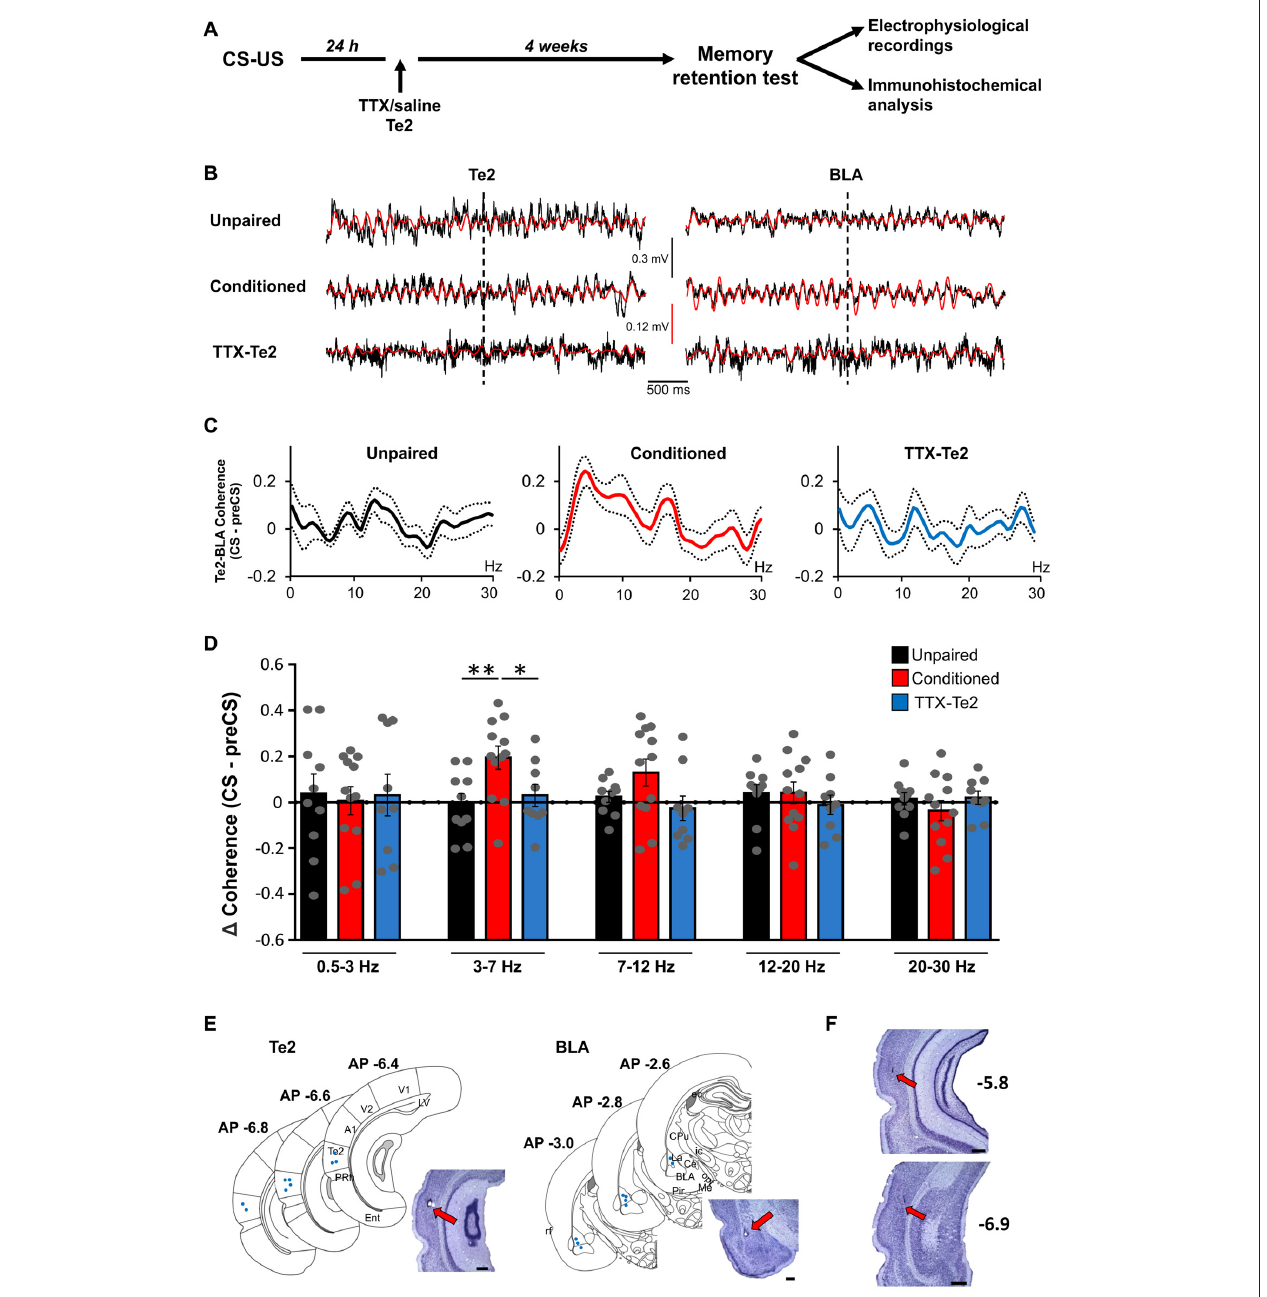
FIGURE 2 | Te2 silencing upon memory consolidation prevented the increase in synchrony between Te2 and BLA activity during long-term memory retrieval. (A) Schematic diagram illustrating the experimental procedure employed to identify the role of Te2 in the retrieval vs. storage of fearful memories. (B) Representative local field potential (LFP) traces recorded in Te2 (left) and BLA (right) with their 3–7 Hz filtered signal superimposed (in red) around the first CS (dotted line). (C) Changes in the coherence between the BLA and the Te2 in unpaired ( n = 10), conditioned ( n = 12) and TTX-treated animals ( n = 9) retrieving long-term memories. (D) Coherence between the Te2 and BLA was unchanged in TTX-treated animals (low-theta (3–7 Hz), 0.47 ± 0.29; high-theta (7–12 Hz), − 0.18 ± 0.41) compared to unpaired animals (sign-rank, P = 0.179 and P = 0.199, respectively), but significantly lower relative to conditioned rats within the low-theta (sign-rank, P = 0.022). Representative histology of electrode tracks in Te2 and BLA of TTX-injected rats ( n = 9) (E) and schematic localizations of electrode tips in the Te2 (left) and BLA (right). (F) Representative Nissl-stained sections showing that the administration of TTX into the Te2 cortex did not induce significant neuronal damage. The sections were taken at two different antero-posterior stereotaxic coordinates from the bregma. A1, primary auditory cortex; BLA, basolateral amygdala; Ce, central amygdala; CPU, caudate putamen (striatum); ec, external capsule; Ent, entorhinal cortex; ic, internal capsule; La, lateral amygdala; LV, lateral ventricle; Me, medial amygdala; opt, optic tract; Pir, piriform cortex; PRh, perirhinal cortex; rf, rhinal fissure; Te2, secondary auditory cortex; V1 and V2, primary and secondary visual cortices. Plates are adapted from the atlas of Paxinos and Watson (1986). Te2 was defined according to the atlas of Zilles (1985). Scale bars, 500 µ m. ∗ P < 0.05; ∗∗ P < 0.01.